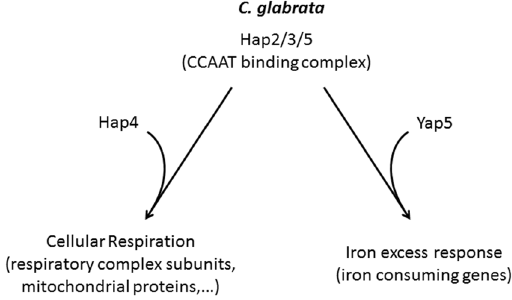
Figure 5. A dual role for CBC in Candida glabrata . CBC plays a dual role in the control of cellular respiration (together with the regulatory subunit Hap4) and of the iron stress response mediated by the Yap5 transcription